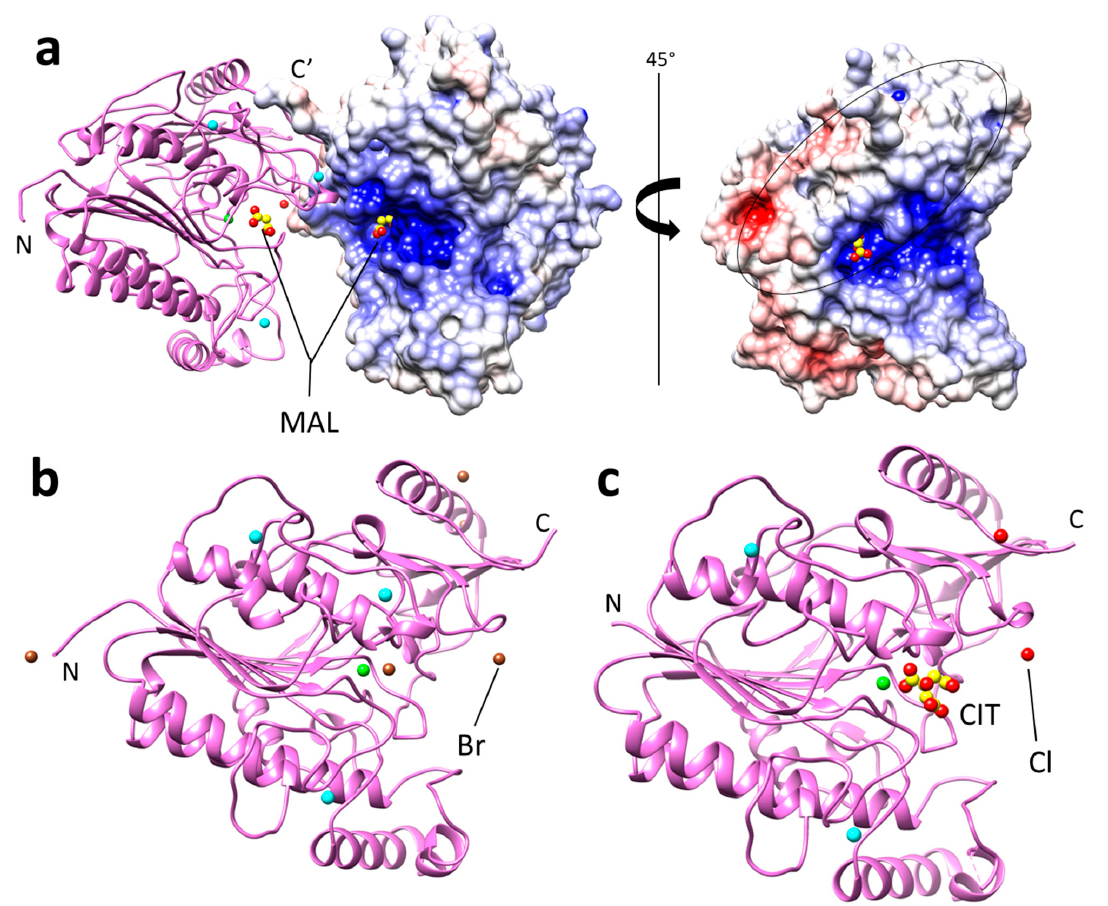
Figure 4. ( a ) Predicted homodimer of PyuS (PDB code: 7STT) with calcium (green) and malonate (MAL) bound in the active site, as well as sodium (teal) and chlorine (red) ions bound on the protein surface. The dimer interface is mainly formed through electrostatic interactions (black oval). One monomer is shown in cartoon representation (pink) while the other is shown in a surface represen- tation of the electrostatic map (red indicates negative charge, white indicates neutral charge, and blue indicates positive charge). The N indicates the N-terminal of monomer 1, and C’ indicates the C-terminal of monomer 2. ( b ) PyuS crystal structure 7STU with sodium (teal), calcium (green), and bromine (brown) ions bound. ( c ) PyuS crystal structure 7STV with citrate (CIT) and sodium (teal), calcium (green), and chlorine (red) ions bound.